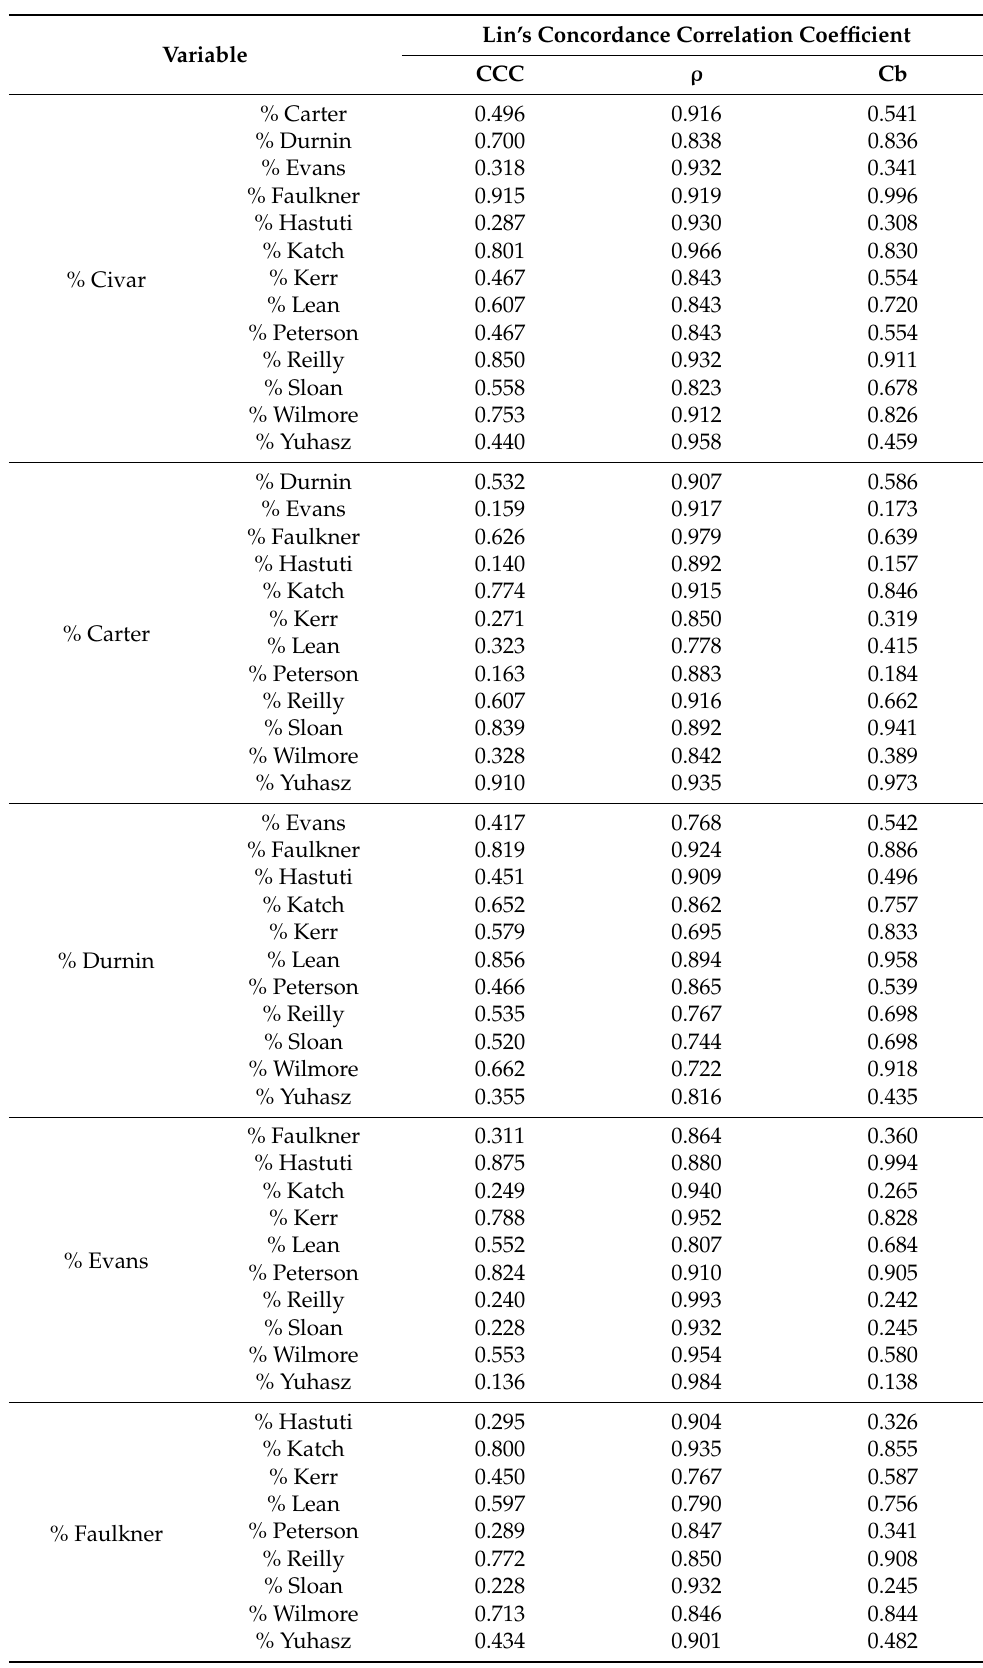
Table 5. Lin’s concordance correlation coefficient between the different formulas in